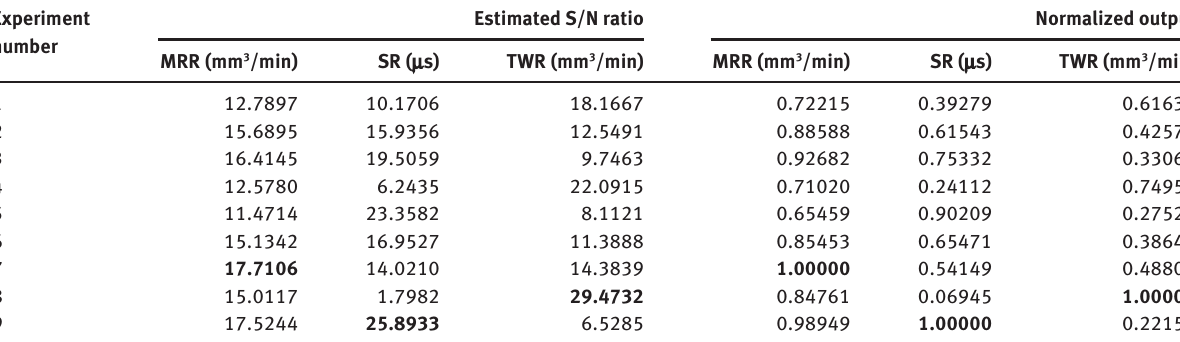
Table 13: Analysis of normalized output parameters ratio in the machining of Al/5%Al